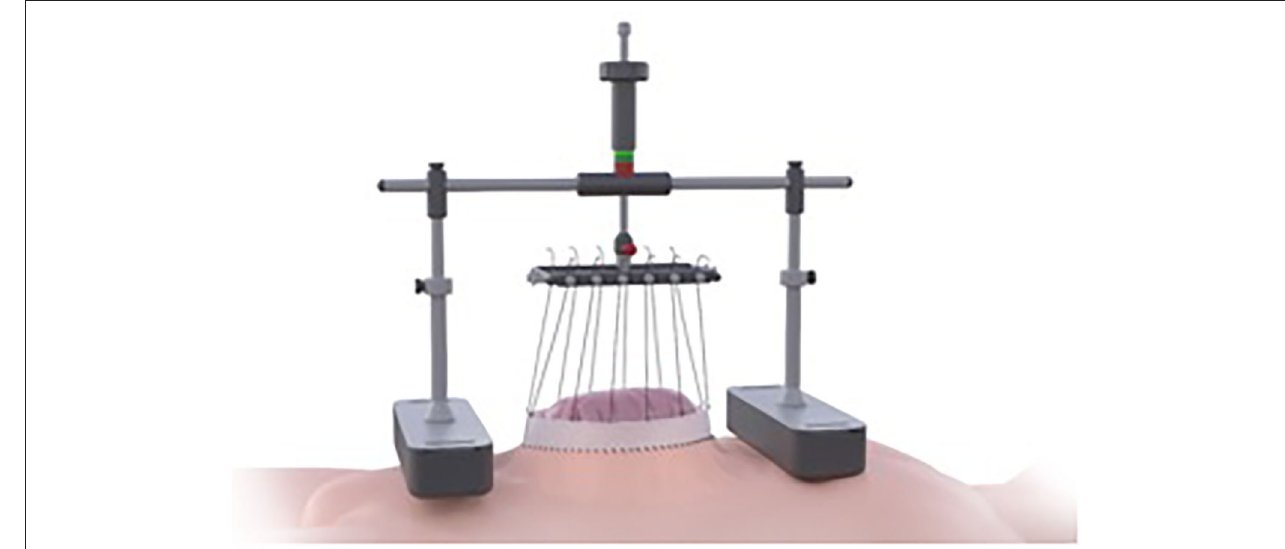
FIGURE 2 | Patient 1 preoperative longitudinal hernia, private archive Dr. M. Renter 7.